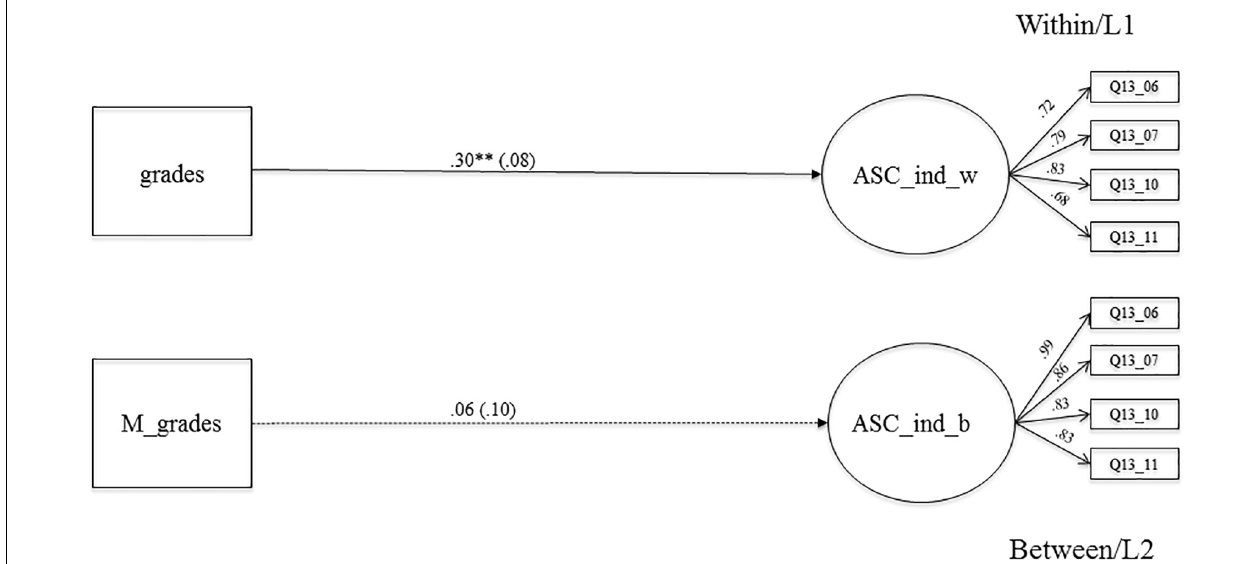
FIGURE 4 | The relationship between averaged grades in Math, German, English as a foreign language. Biology and individual academic self-concept on the within and between level. Level 1, student level; Level 2, classroom level; regression coefficients were standardized by group-mean-centering; grades, averaged grades at the end of the school year 7 (Math, German, English as a foreign language, Biology); ASC_ind_w, individual academic self-concept on LI (within); M_grades, aggregated mean-grades on L2; ASC_ind_b, individual academic self-concept on L2 (between); bold pathways are significant at ∗ p < 0.05, ∗∗ p < 0.001; dotted pathways are not